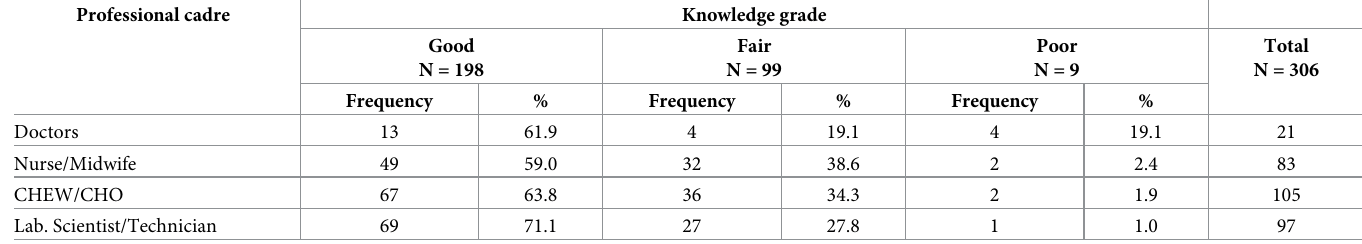
Table 2. Level of knowledge of malaria rapid diagnostic test by professional cadre of respondents in selected health facilities, Zamfara state. Professional cadre